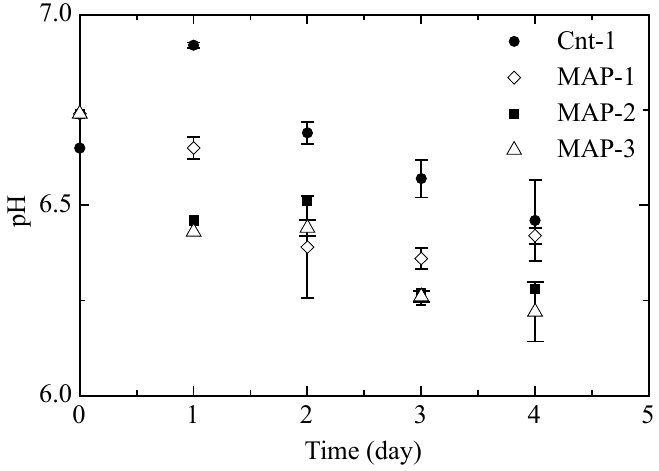
Figure 2. pH value of brine for samples packaged in air and under MAP.